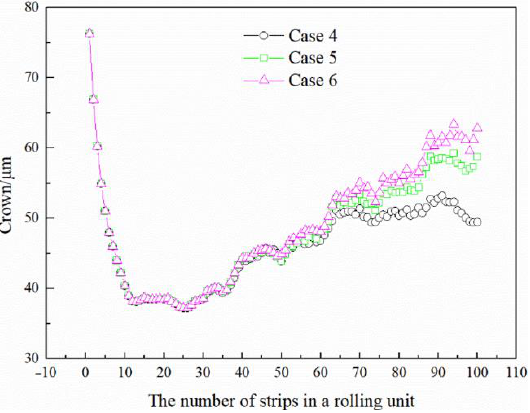
Figure 13. Strip crown distribution in a rolling unit with different roll shifting amplitude.